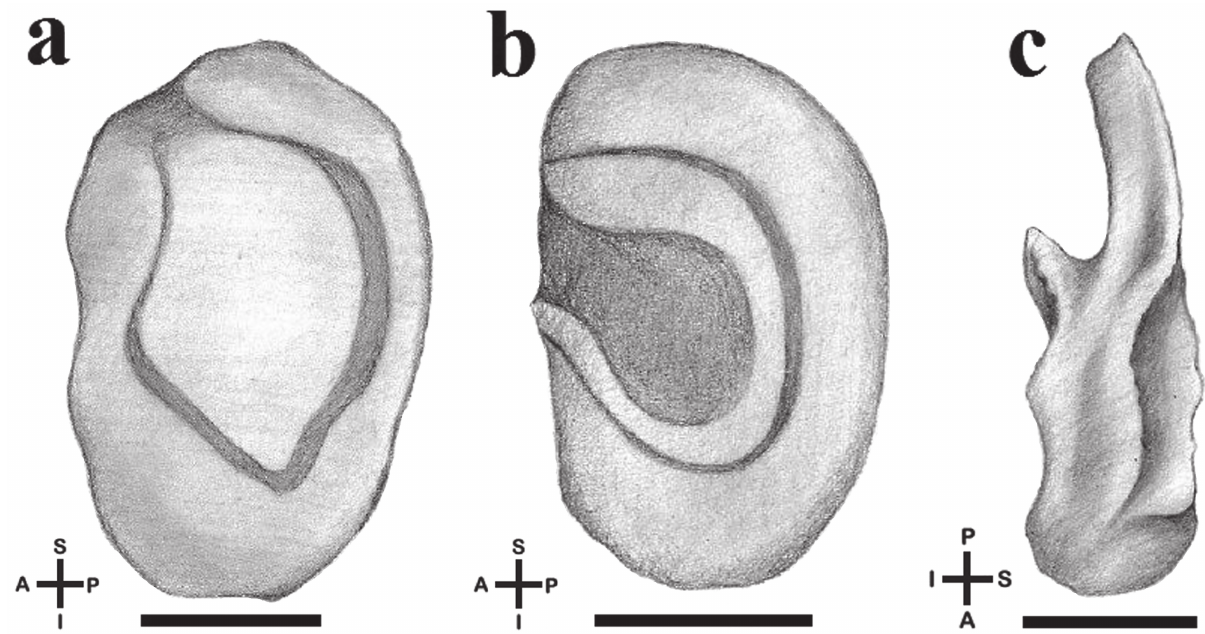
Fig. 3. Right serie of otoliths of Otocinclus vittatus (a) Lapillus, Scale bar = 200 µm; (b) Asteriscus, Scale bar = 200 µm; (c) Sagitta, Scale bar = 200 µm.